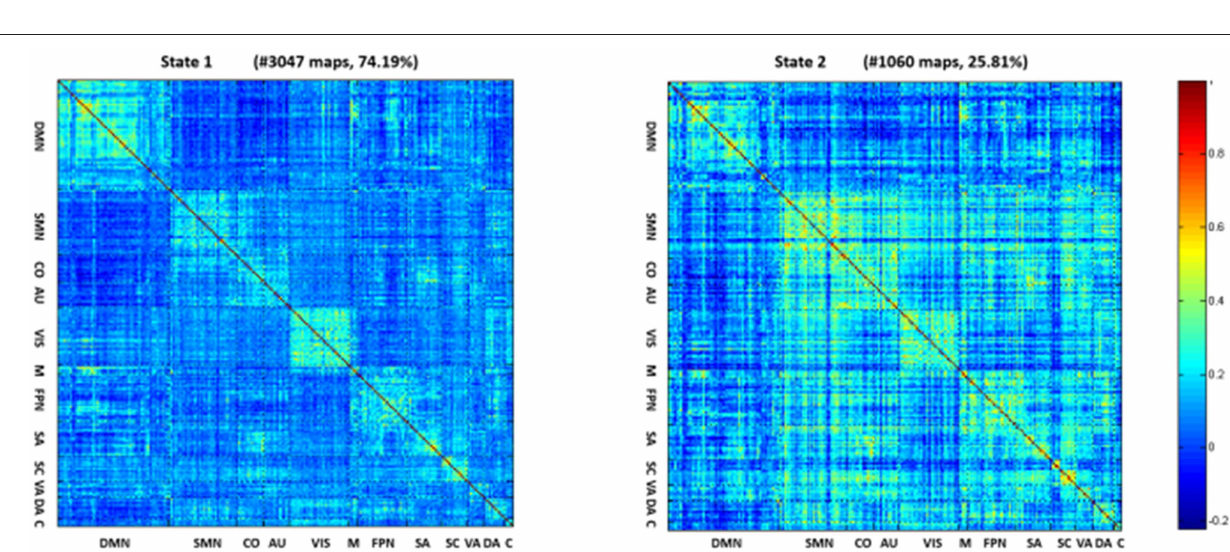
FIGURE 2 | Centroids of the two dFNC states. In state 1, the whole network displayed slight negative connectivity and slight positive connectivity intra-networks. State 2 showed moderate positive connectivity within and between most inter-networks, while the connectivity was negative between DMN and others.